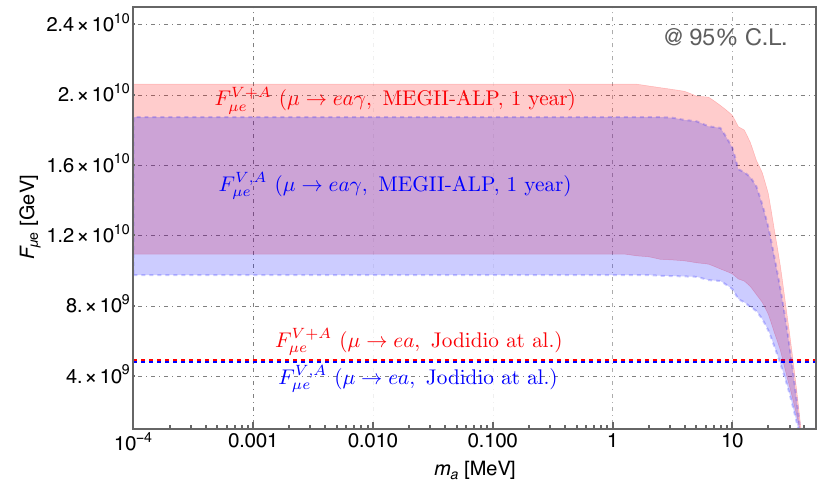
Figure 9 . 95% C.L. limits on F µe for different chiralities. Red (blue) solid bands indicates the reach of µ → eaγ search with V + A ( V or A ) interaction for LFV coupling of ALP, assuming 1 year of running time. The width of the bands correspond to the uncertainty in our estimation of the trigger rate as shown in figure 4. Dashed lines are the current limits from the µ + → e + a search performed by Jodidio et al. in 1986 [45] for